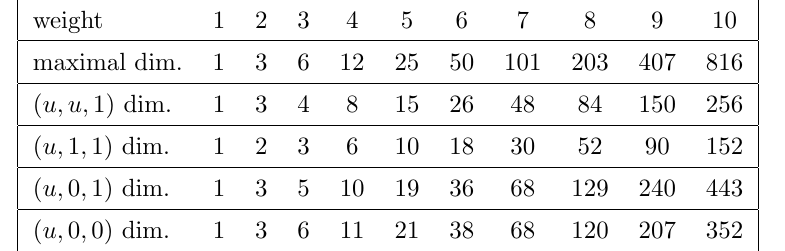
JHEP09(2019)061